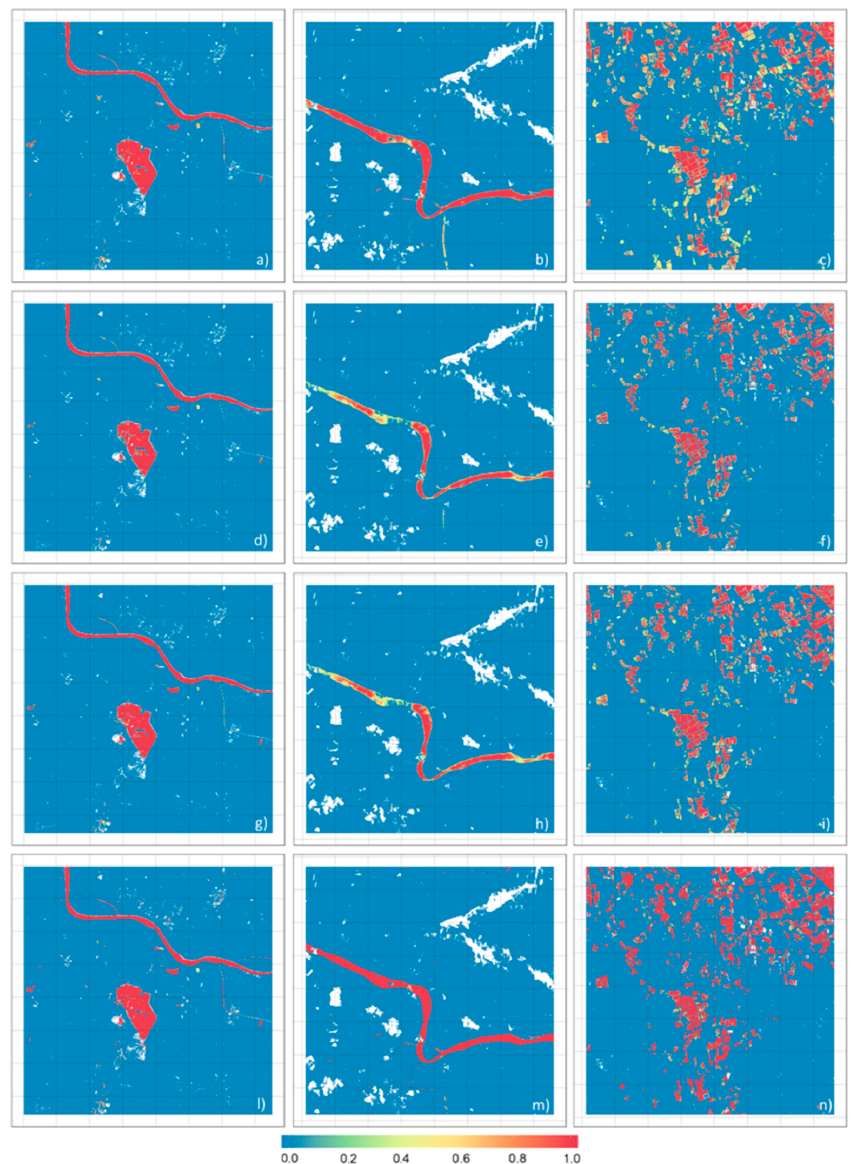
Figure 6. Partial-evidence maps obtained by soft constraints of expert A on AWEI ( a – c ); mNDWI ( d – f ); NDFI ( g – i ) and the hue (H) and value (V) components ( l – n ) for zoom areas of 20 km × 20 km of ROI_1 Emilia area (left), ROI _2 Po Valley (middle) and ROI _3 rice paddies (right). Cloud-masked areas are white, and the degree of partial evidence ranges in [0, 1] [29].